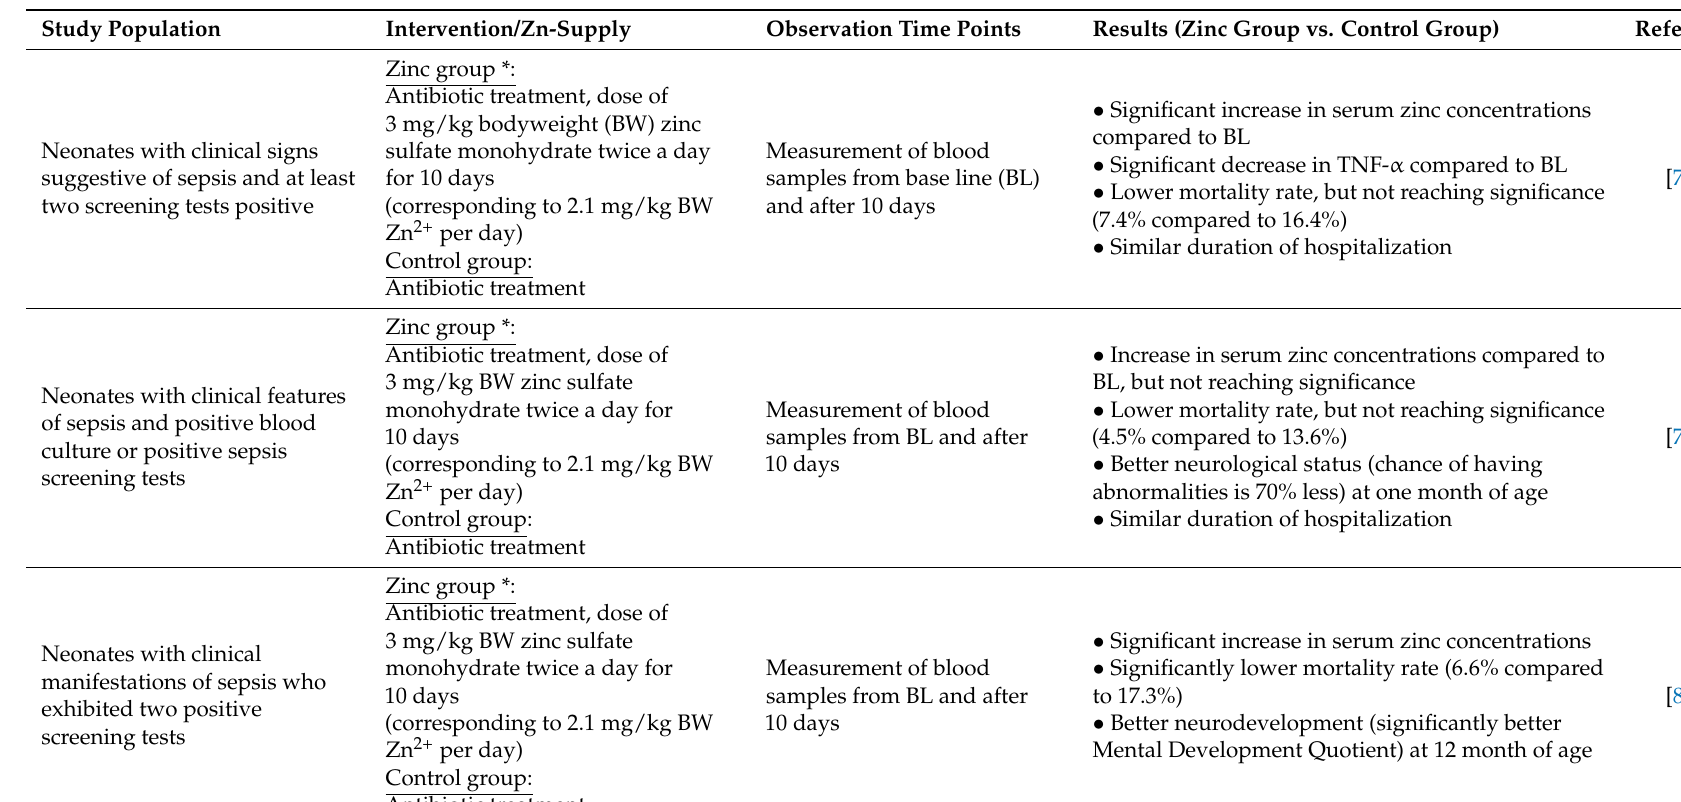
Table 1. Zinc supplementation studies in septic